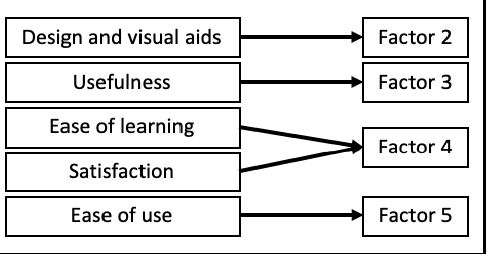
Figure 10: Main factor contributions of each user perception category